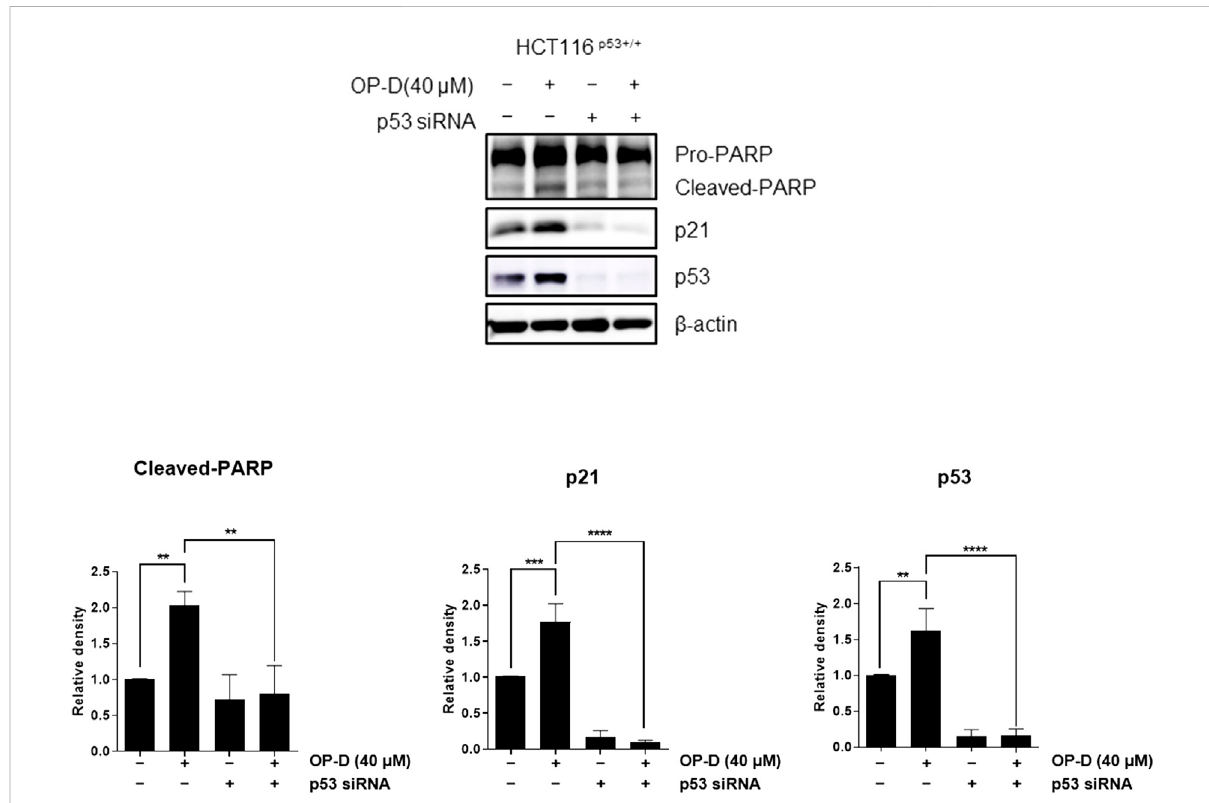
FIGURE 3 OP-D induced apoptosis through activating p53 in HCT116 p53+/+ cells. HCT116 p53+/+ cells were transfected with p53 siRNA for 48 h. After transfected, cells were treated with OP-D (40 μ M) for 24 h. Cell lysates were performed for PARP, p21, p53, and β -actin by Western blotting. Data represent means ± SD. ** p < 0.01, *** p < 0.005, **** p <